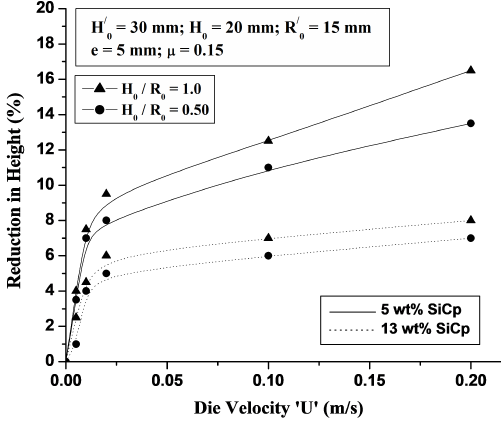
Fig. 8. Variation of Preform Height Reduction with Die Velocity.